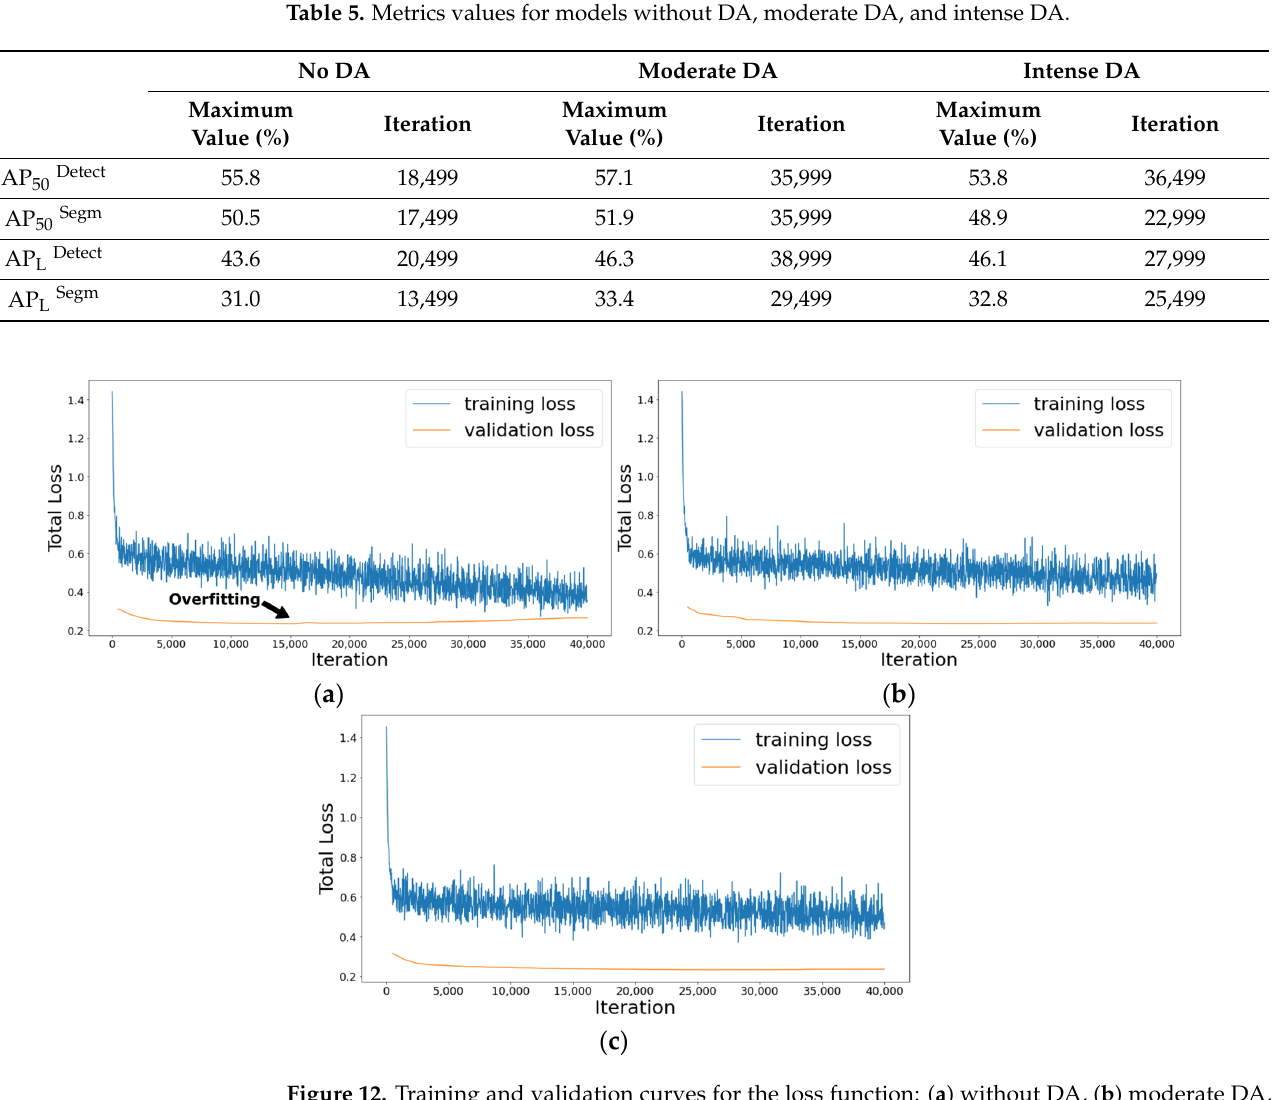
Table 5. Metrics values for models without DA, moderate DA, and intense DA.